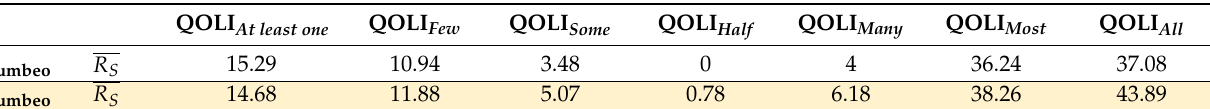
Table 13. The average rank difference between Numbeo’s QOLI and other QOLI produced b y diverse linguistic quantifiers (number versus. 2-tuple value).